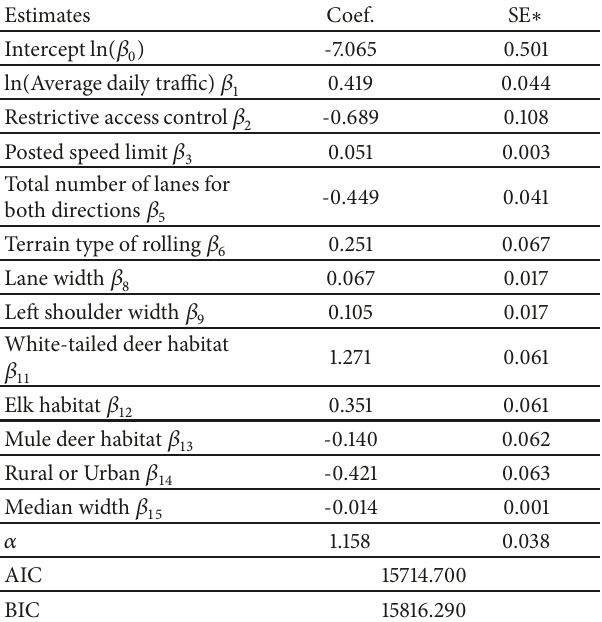
Table7:Differencesinrankingbetweenthecarcassremovalandthe reported AVC using the NB-based EB